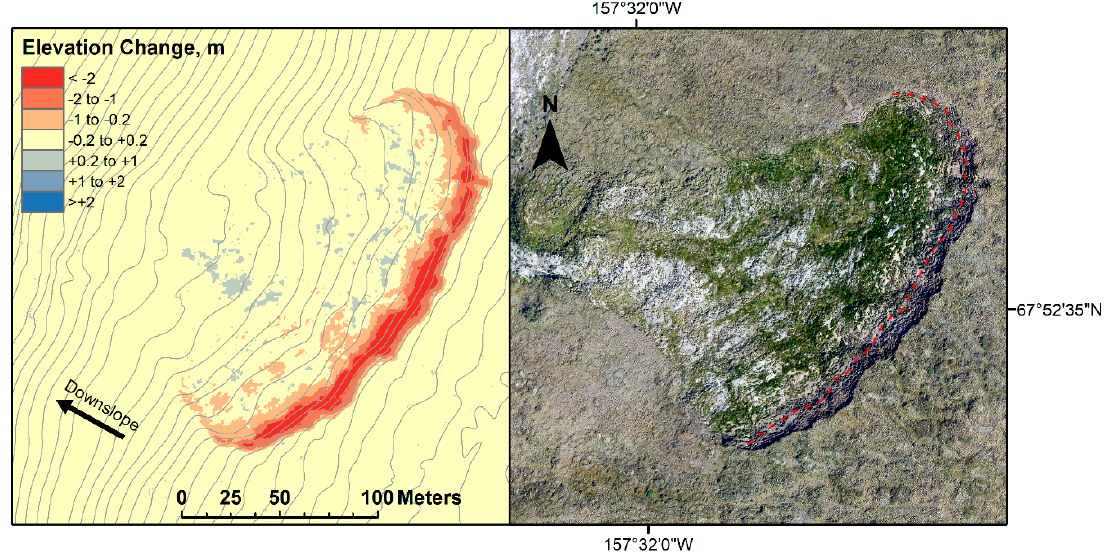
Figure 15. Retrogressive thaw slump NOAT148. The contour map on the left (1 m contour interval) shows elevations in 2016 and the elevation change from 16 September 2013 to 11 July 2016. The orthophotograph on the right is from 2016, with the 2013 scarp position noted. The volume change in the upper subsidence zone (red) was − 6529 m 3 .